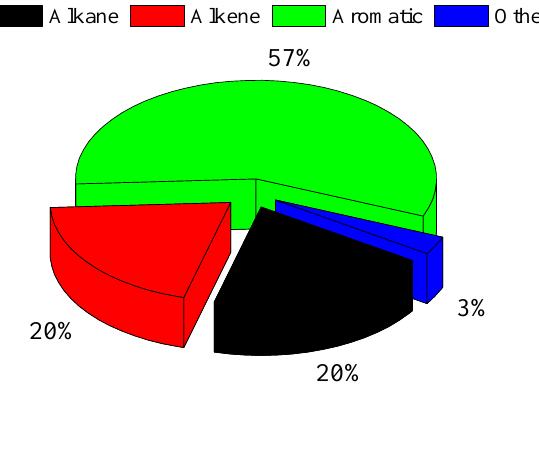
Figure 9. Contributions to ozone formation by different VOC groups (alkanes, alkenes, aromatics, and others).